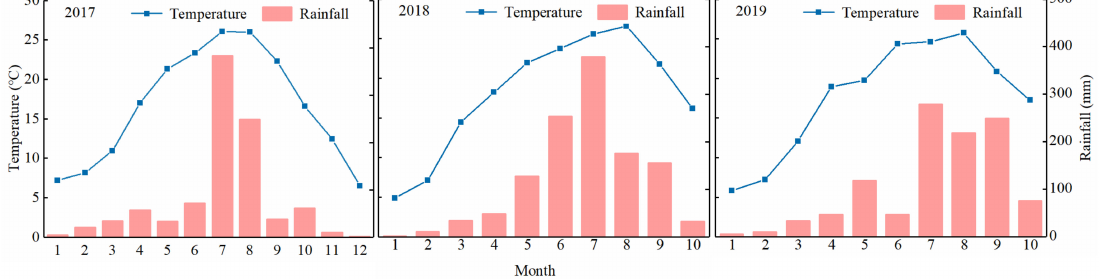
Figure 1. Meteorological data of the experimental area, including temperature and rain full in